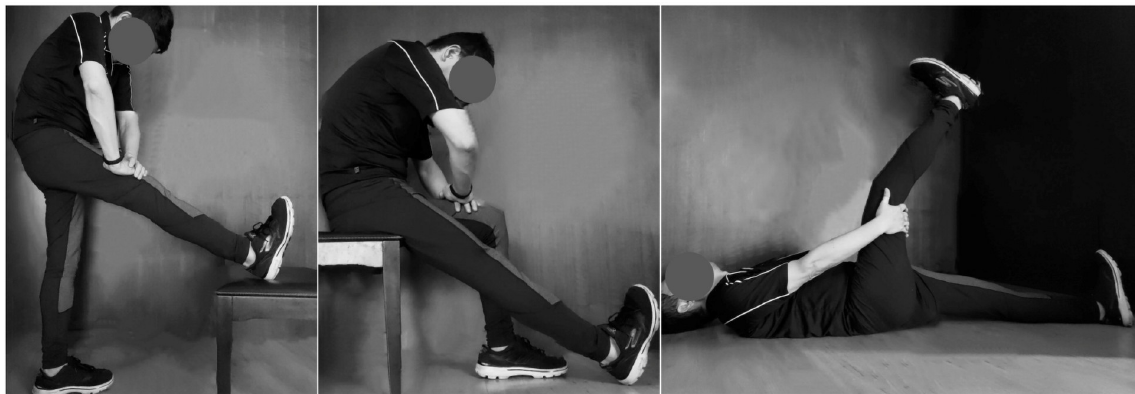
Fig 1. Schematic of stretching postures adopted in the training